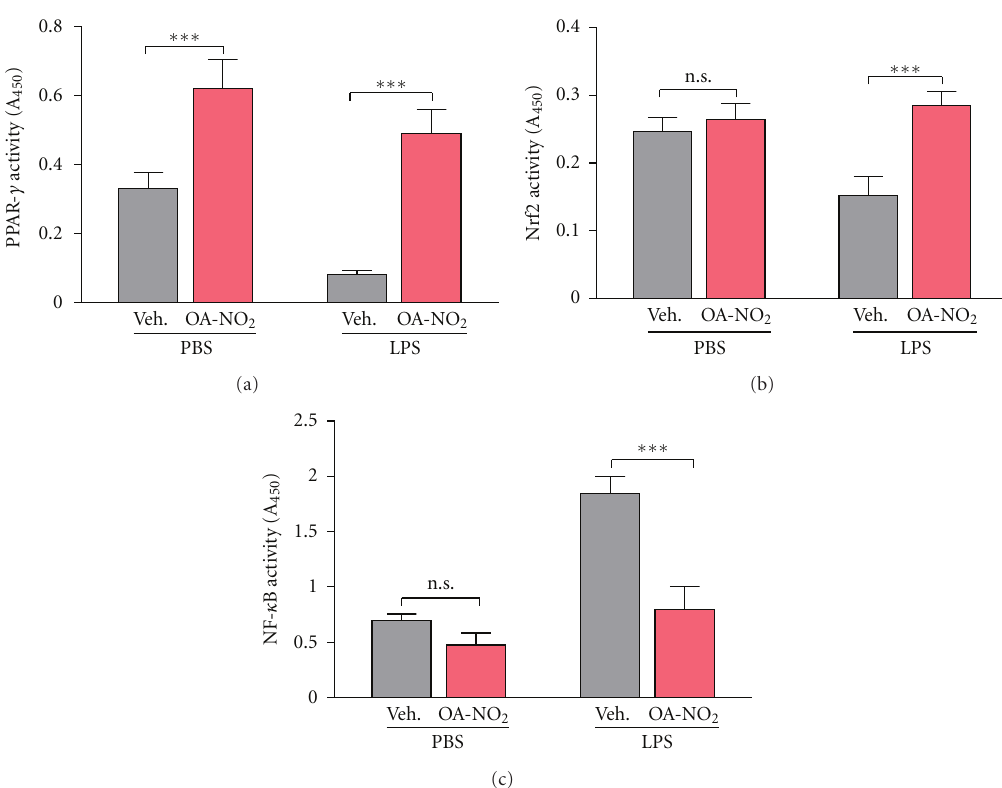
Figure 4: OA-NO 2 reverses LPS-induced changes in transcription factor activity. Induction of ALI by i.t. injection of LPS (50 μ g) was followed 30 min later by i.t. administration (50 μ L) of OA-NO 2 (50 μ g) or vehicle (10% DMSO). After another 5.5 h lungs were excised and DNA-binding activity of the transcription factors (a) PPAR- γ , (b) Nrf2, and (c) NF- κ B was determined. Data are representative of one of two independent experiments with n = 6–8 mice per group; ∗∗∗ P <